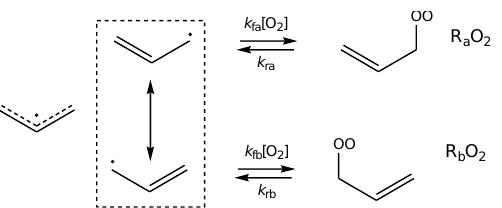
Figure 10. Root mean square error, mean absolute error, mean bias error and box plot for the error distribution in the estimated log k 298K values for various subsets of monofunctional aliphatic species. The bottom and the top of the box are the 25th ( Q 1 ) and 75th percentiles ( Q 3 ), the black band is the median value. The whiskers extend to the most extreme data point which is no more than 1.5 × ( Q 3 – Q 1 ) from the box. The points are the extrema of the distribution. The black dotted lines correspond to agreement within a factor 2.